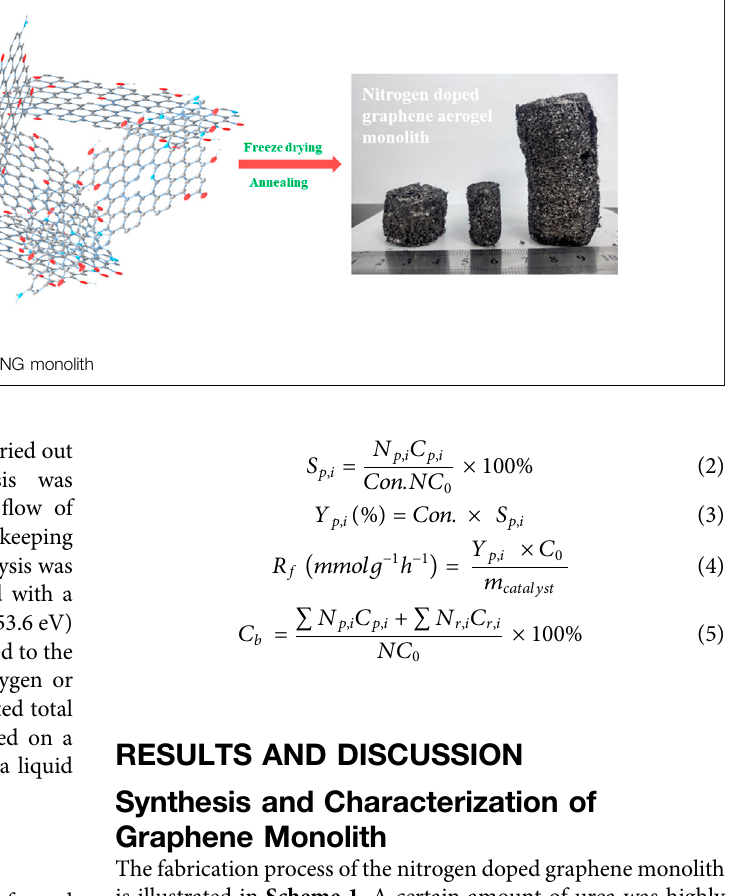
Frontiers in Chemistry |